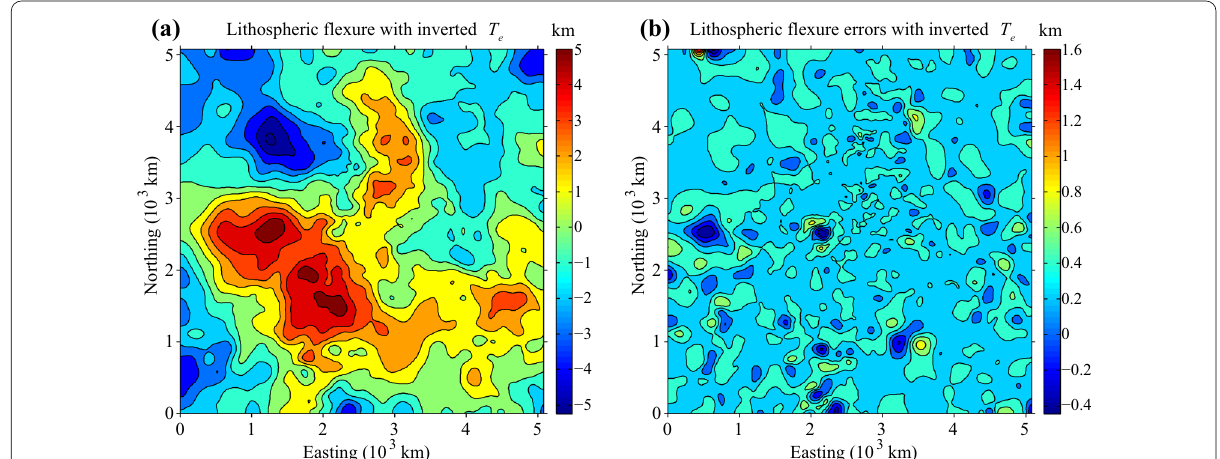
Fig. 5 a Lithospheric flexure using the inverted T e grid. b Lithospheric flexure errors for the model inversion using the inverted T e grid